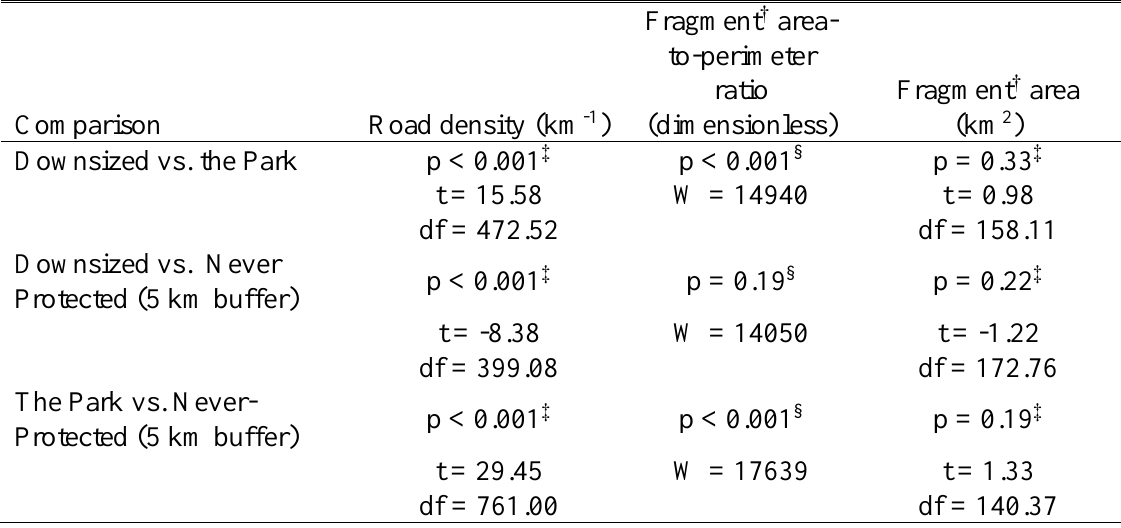
Table A1.2: Post-hoc results from Table A1.1. Habitat fragmentation at the Park scale for forested lands using 5 km buffers for never-protected lands. Results are consistent with comparisons using a 1 km